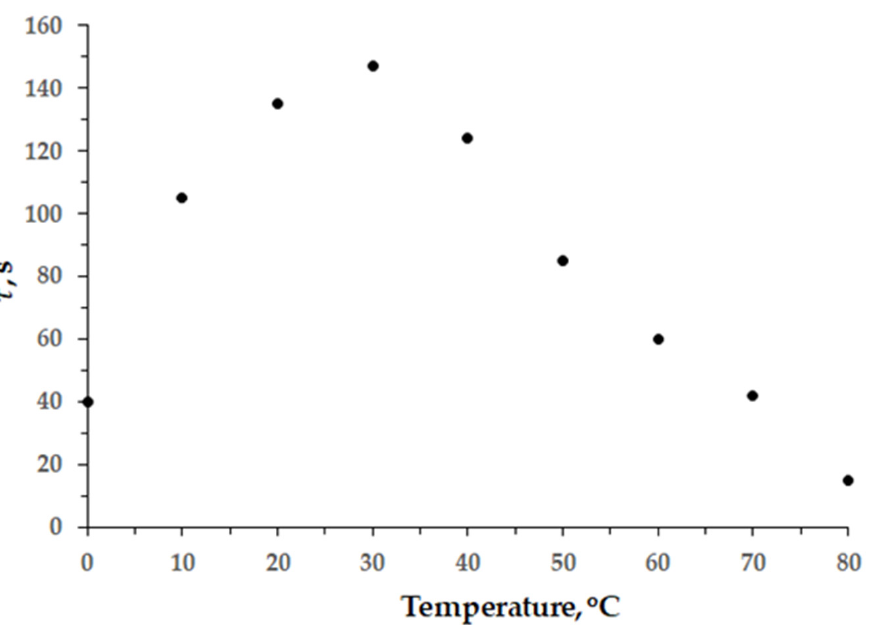
Figure 7. Time of the protective action of coatings formed after etching AMg6 alloy in 10 wt% aqueous solution of sodium hydroxide followed by hydrophobization with a stearic acid solution (3 g·L − 1 ) in a DMSO/H 2 O binary mixture (7:1 v / v ) at 40 °C for various modification times.